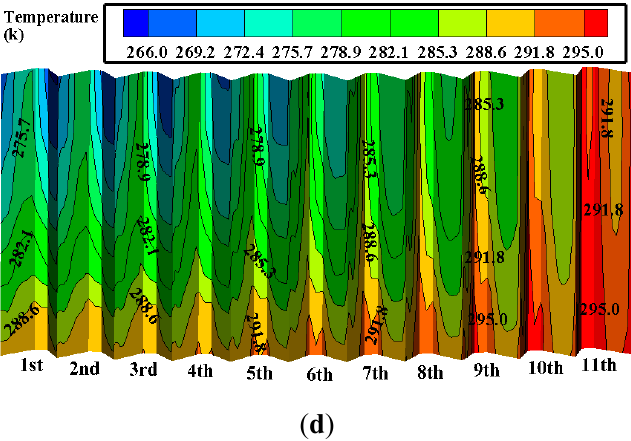
Figure 10. Variable fields of the middle-front deltas. ( a ) Pressure and flow fields at 4 m/s, ( b ) pressure and flow fields at 12 m/s, ( c ) outlet air temperature at 4 m/s, ( d ) outlet air temperature at 12 m/s.